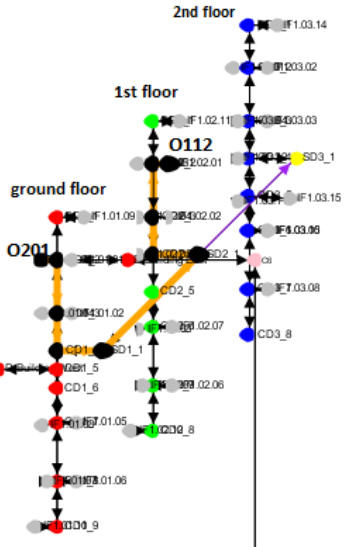
Figure 10. Buildings D, E and F.